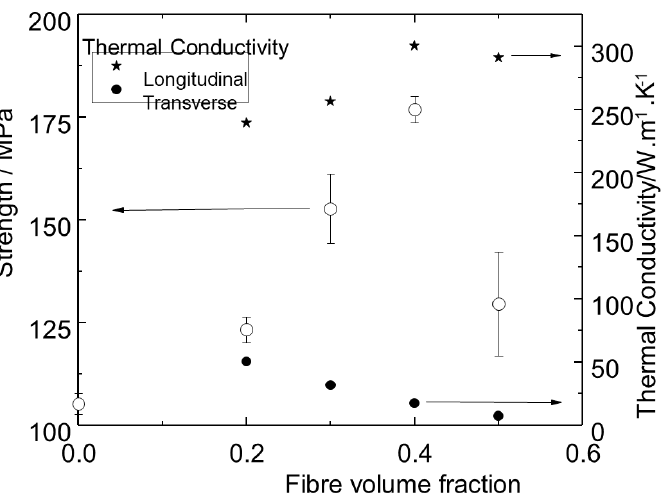
Figure 5. Strength and thermal conductivity of the carbon-fibre/aluminium-matrix composite versus the fibre volume fraction. Experimental data published in [23].